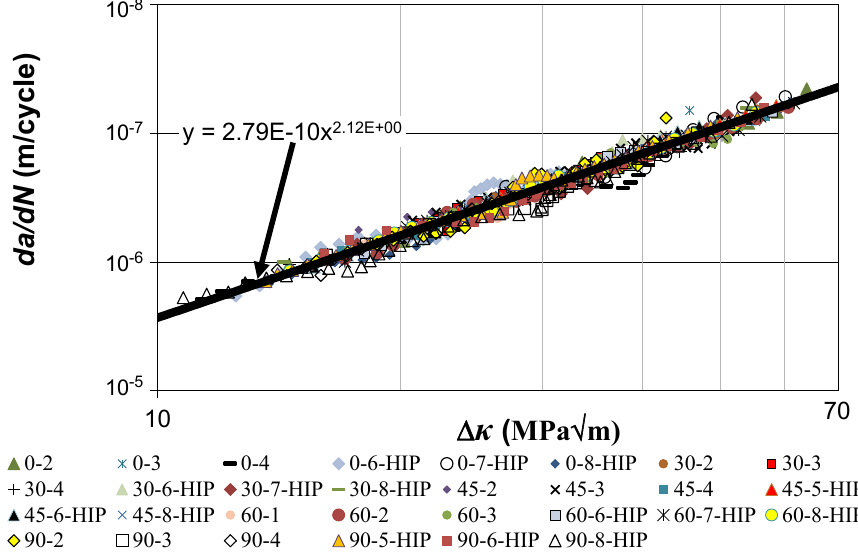
Figure 2. Hartman–Schijve representation of the thirty SLM Ti-6Al-4V tests. To further illustrate the variability associated with AM Ti-6Al-4V Figure 1 also contains the R = − 1 da/dN versus ∆ K curve determined in [17] for a short surface crack in a specimen built using a Renishaw AM250 LB-PBF machine. In this instance the maximum applied stress was 268 MPa. This curve is labelled LB-PBF2. The cyclic fracture toughness ( A ) √ of the material in this test was found to be approximately 37 MPa m and the fatigue √ threshold term ( ∆ K thr ) was approximately 0.1 MPa m, see [17]. Here, it should be